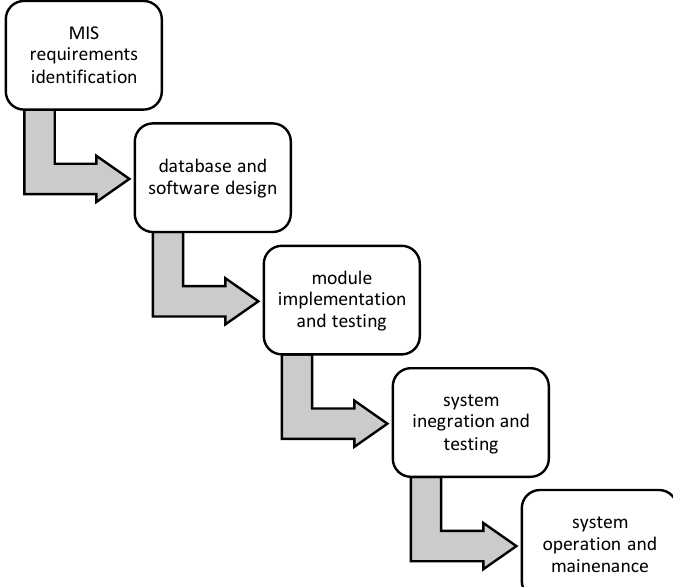
Fig. 20. Waterfall model for management information system.